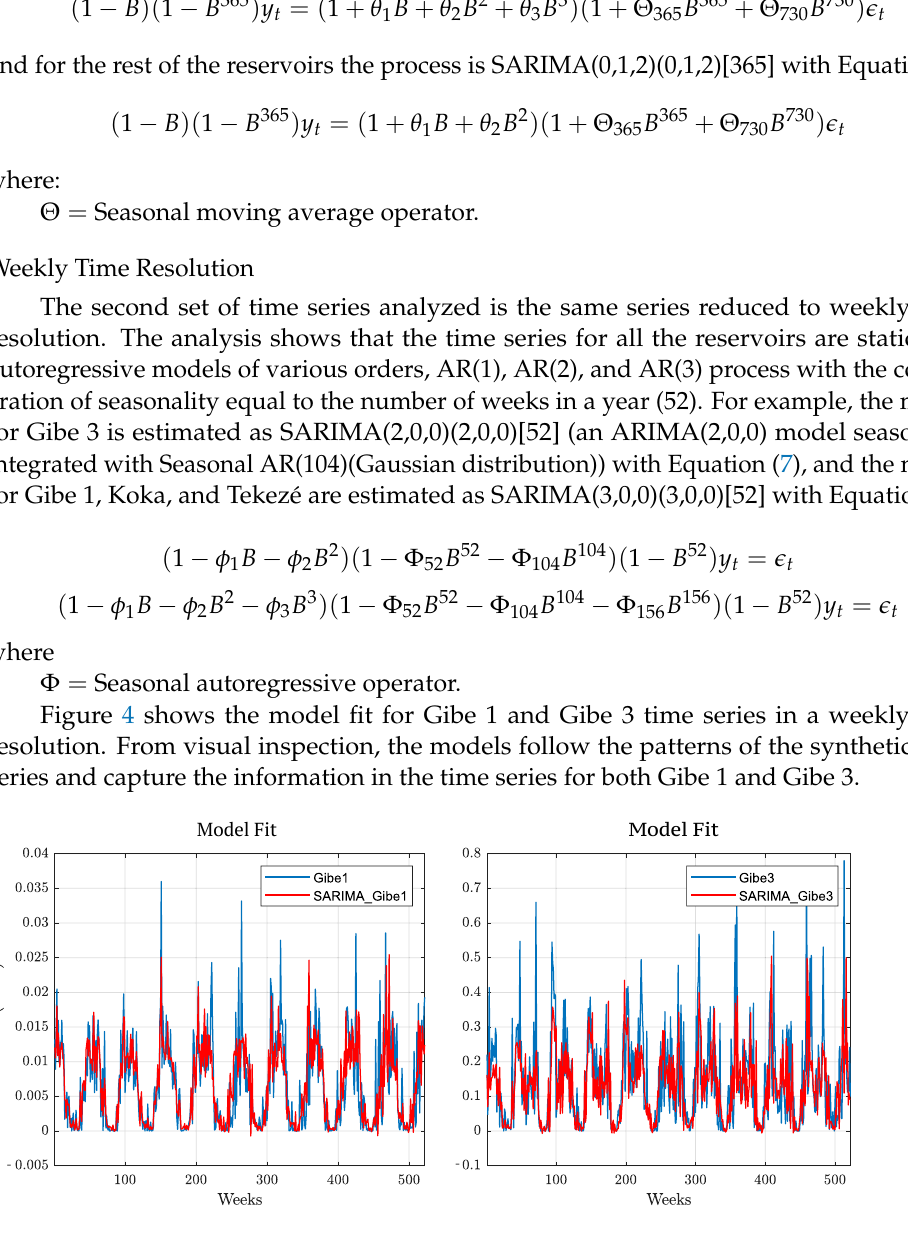
Figure 4. Model − 1 fit for the Gibe 1 and Gibe 3 time series in the weekly time